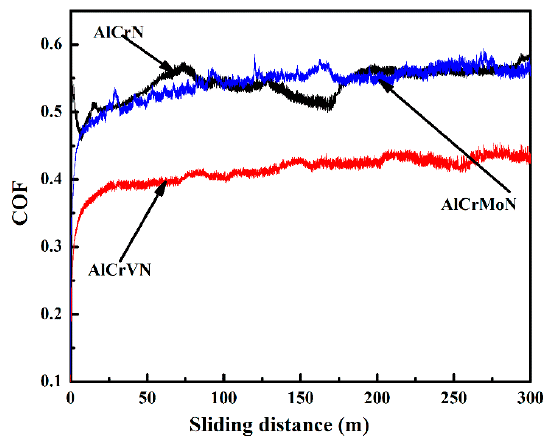
Figure 4. Friction coefficients of the coatings on coated CC substrates.